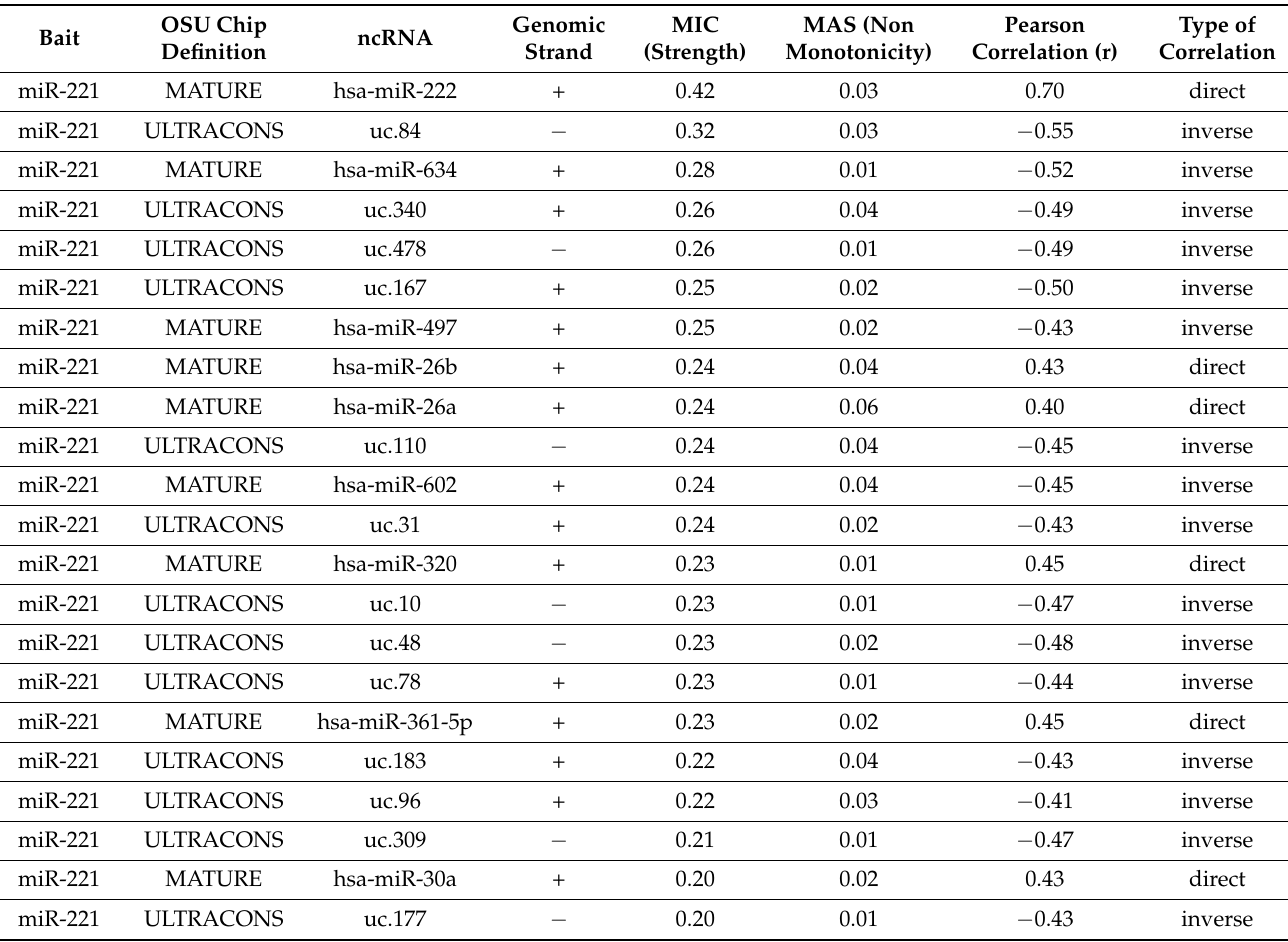
Table 1. Data mining results for co-regulations of T-UCRs and miR-221. The name and genomic strand of both miRs (MATURE) and T-UCRs (ULTRACONS) correlated with miR-221 (bait) are reported, after selection of those with MAS ≥ 0.01, MIC ≥ 0.2, and abs(r) ≥ 0.4 threshold. The OSU microarray chip has probes for mature miRNAs (which tend to be conserved in the genomic sequences) and ultraconserved UCRs.